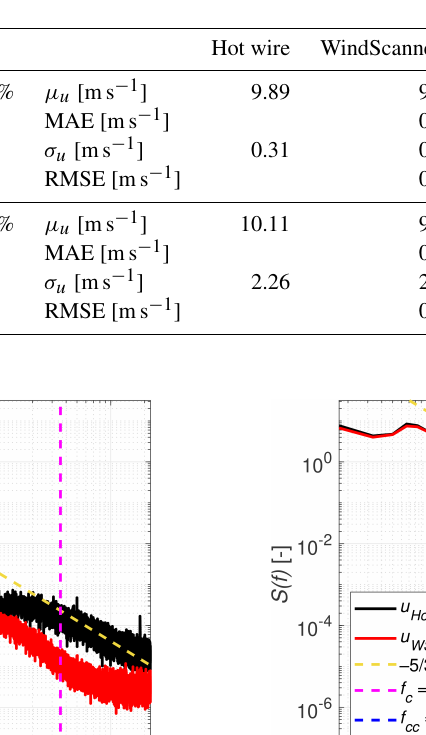
Table 3. Statistics of the 10min hot-wire and WindScanner time series of the u component of the wind.